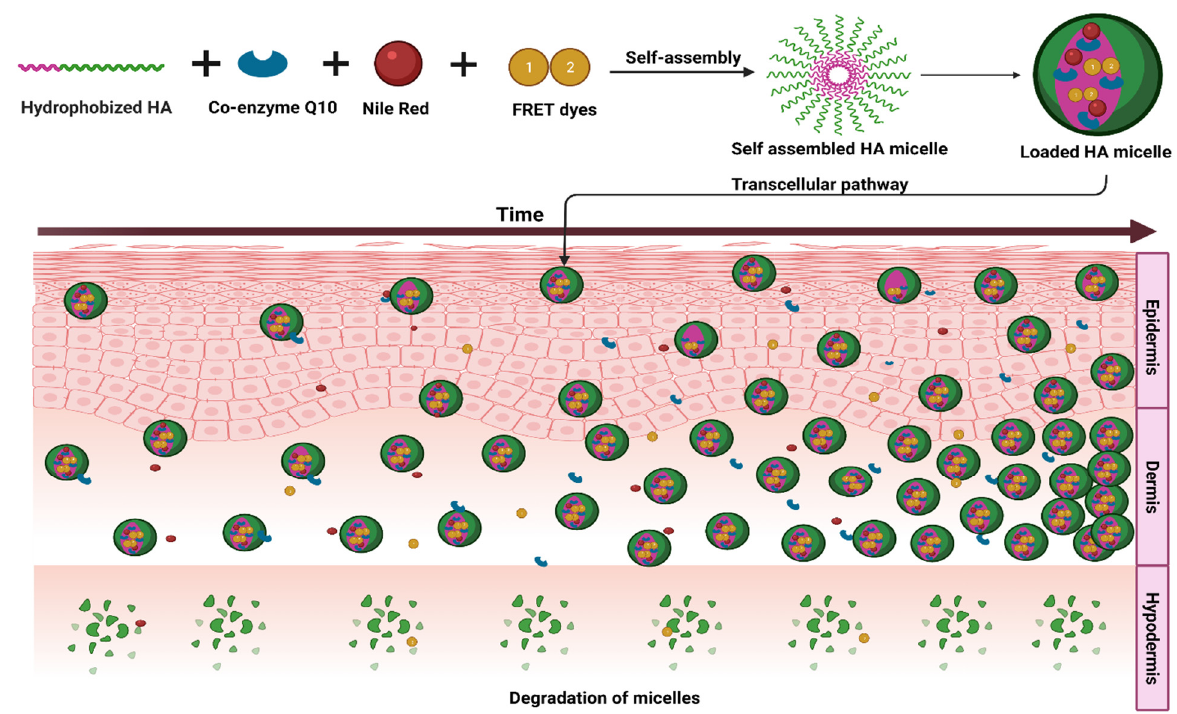
Figure 7. Synthesis of HA micelle and its internalization and accumulation pattern on skin layers.